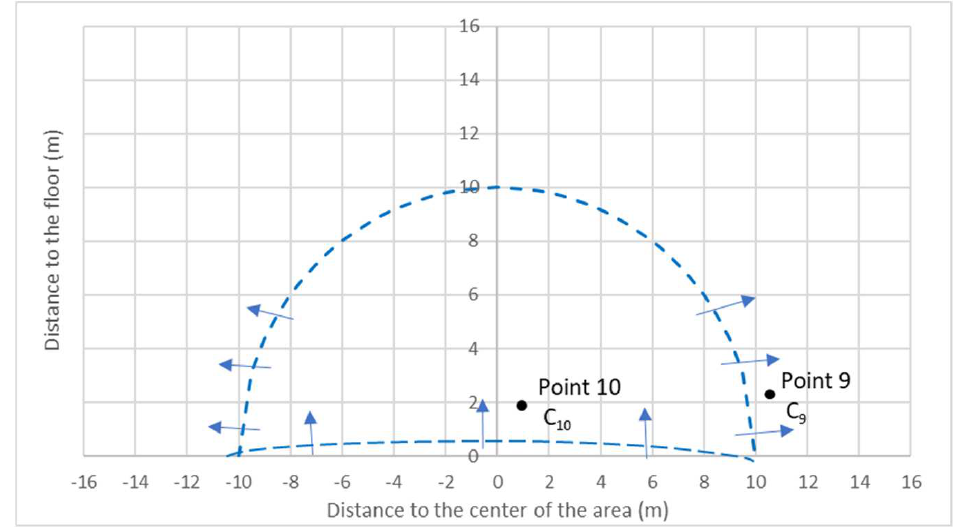
Figure 5. Simplified sketch of the gaseous Hg emissions (flat and hemispherical flux).